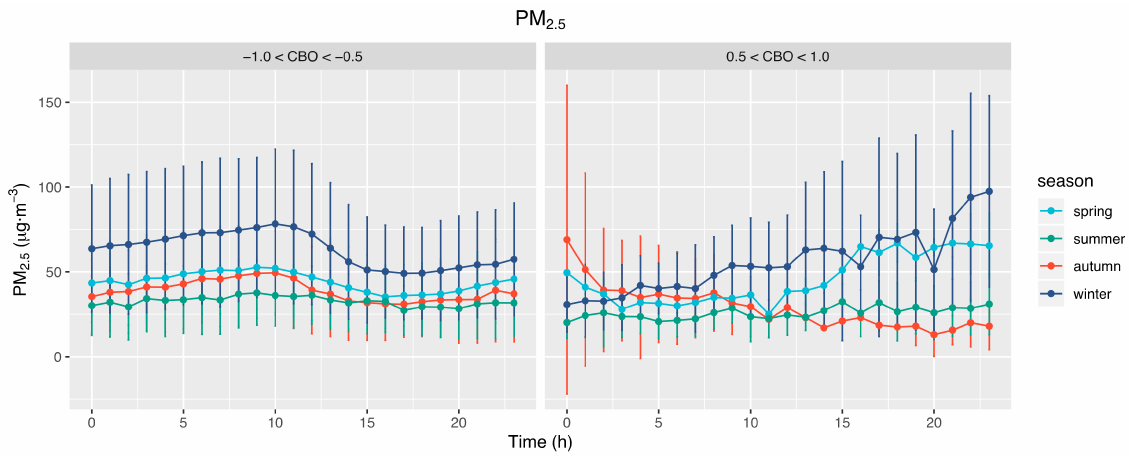
Figure 8. Diurnal variations of PM 2.5 in two situations: ( left ): − 1.0 < CBO < − 0.5 and ( right ): 0.5 < CBO < 1.0. As for NO 2 (Figure 9), (1) while − 1.0 < CBO < − 0.5, the average NO 2 was the highest in winter (53.34 µ g · m − 3 ), and the lowest in summer (33.74 µ g · m − 3 ), and the diurnal variations of NO 2 had a trough between 10:00 and 19:00. (2) In contrast, while